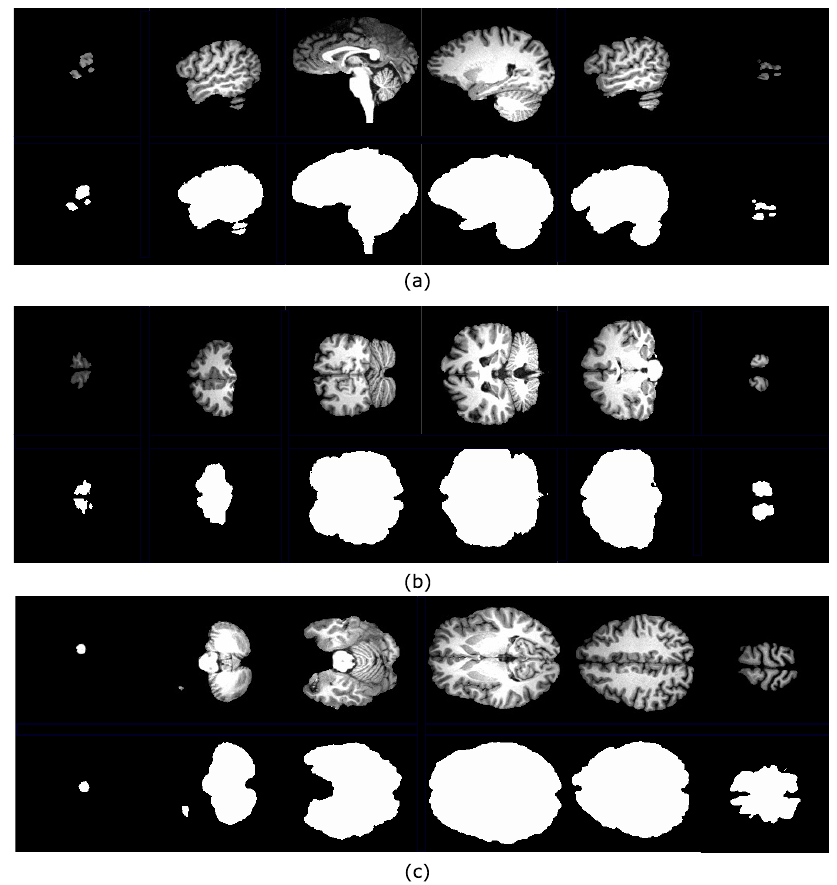
Figure 13. File A00028185 belongs to the NFBS repository. This volume was processed by using the algorithm presented in Figure 8. ( a ) Segmented brain slices in the sagittal plane with their correspond- ing ground truth images; ( b ) segmented brain slices in the coronal plane with their corresponding ground truth images; ( c ) segmented brain slices in the axial plane with their corresponding ground truth